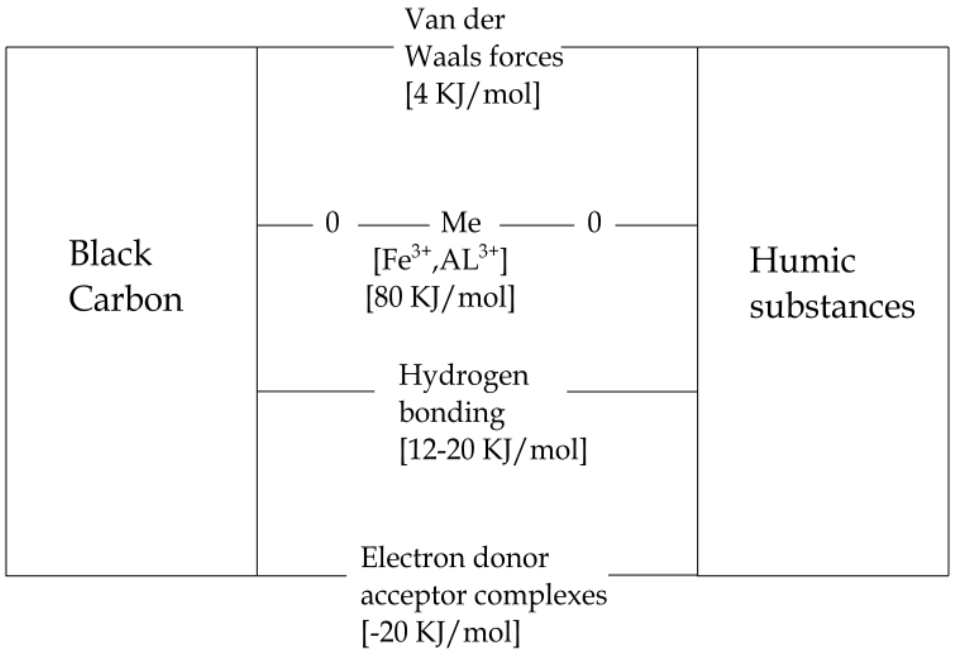
Figure 4. Principal chemical interactions between black carbon molecules and humic substances. In square brackets are approximate bonding energies.